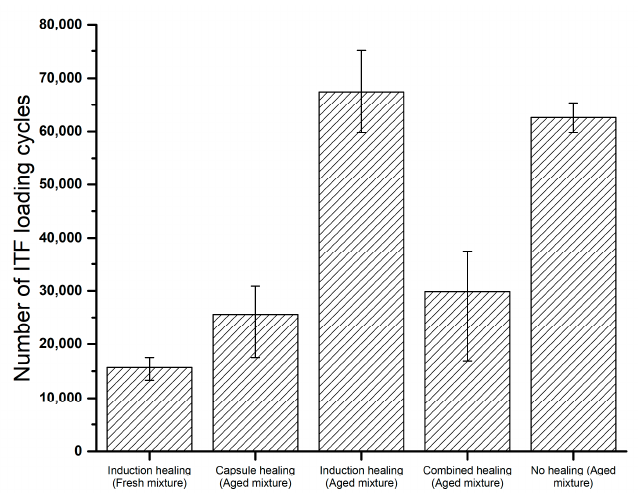
Figure 13. Indirect tensile fatigue results of cylinder specimens from all PA mixture groups.